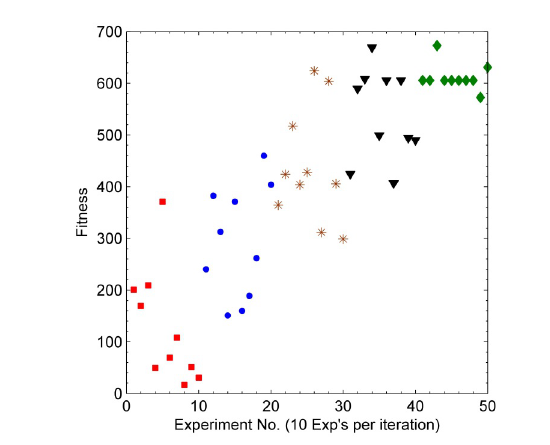
Fig. 8: Evolution of fitness values of all